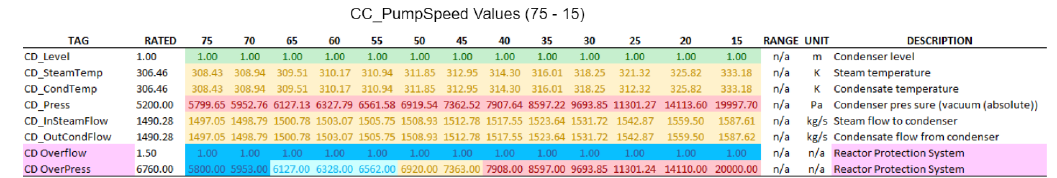
Figure 25. Simulated results (CD—Condenser).